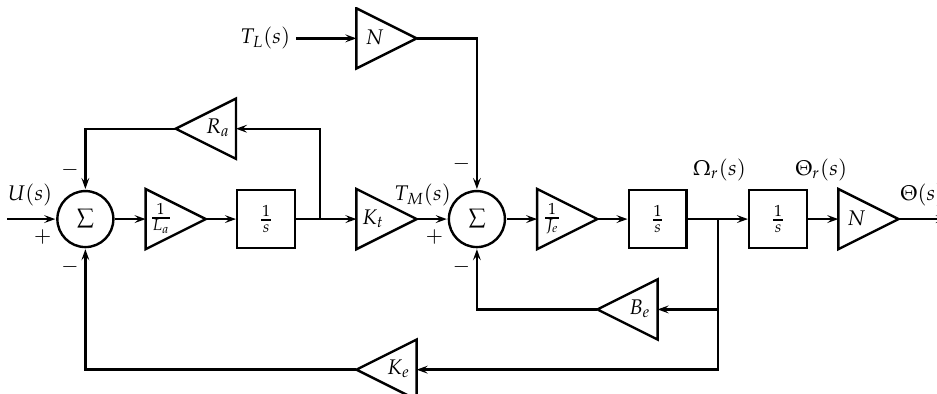
Figure 3. Electromechanical system block diagram.